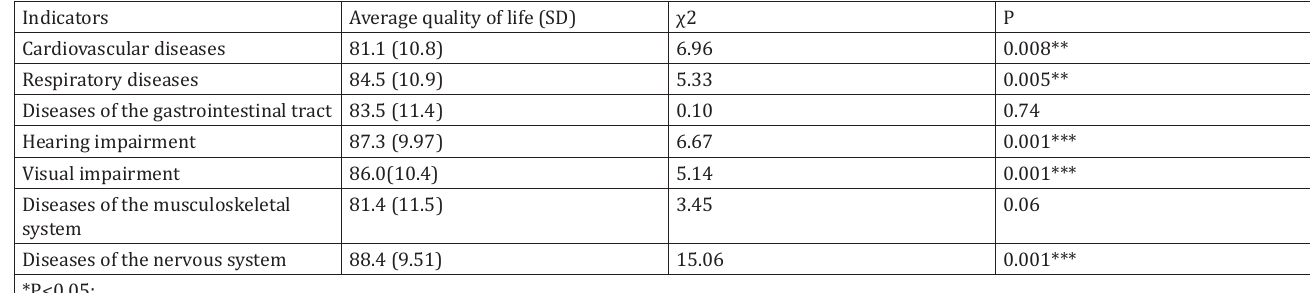
Relationship between Overall Quality of Life and Disease